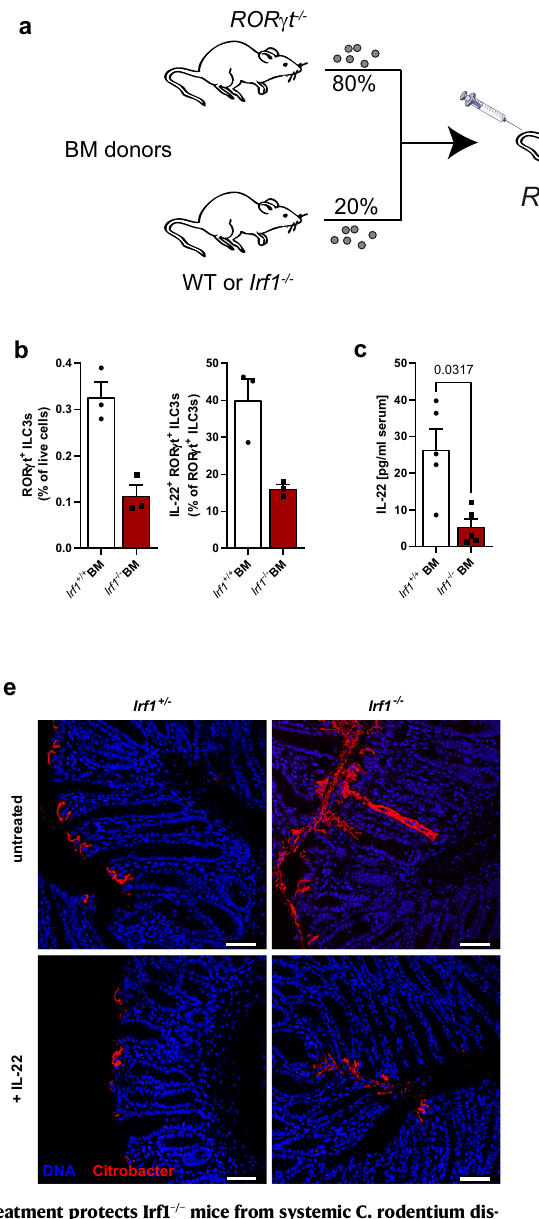
Fig. 8 | IL-22 treatment protects Irf1 – / – mice from systemic C. rodentium dis- semination. a Mixed bone marrow (BM) chimeras with 80% ROR γ t – / – (ILC3 de fi - cient)and 20% control or Irf1 – / – bonemarrow weregenerated.After 8weeks, mice were infected with C. rodentium and analyzed at 8 dpi. b Flow cytometric analysis of ILC3s (lin - Thy1.2 + ROR γ t + ) and ILC3s expressing IL-22 ( n =3/group). c Serum IL- 22concentrationsweremeasuredbyspeci fi cELISA( n =5/group). d Dissemination of C.rodentium wasanalyzedbydeterminationofCFU/gtissuefromlivers,spleens and mLNs ( n =5/group). e , f Control and Irf1 – / – mice were injected with an